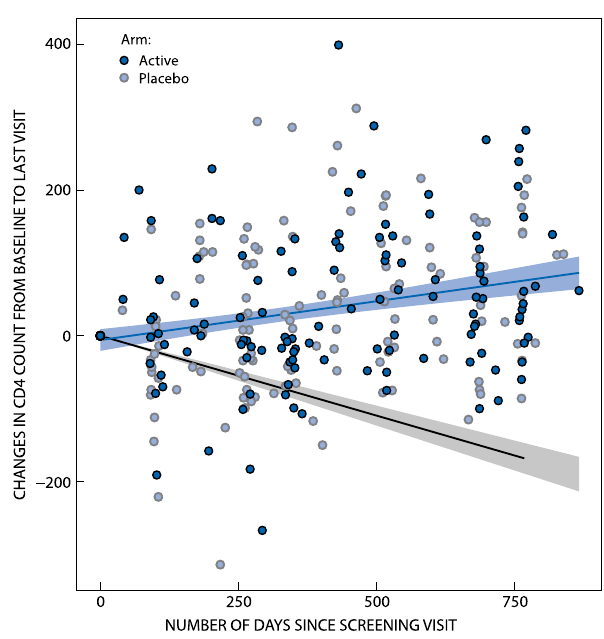
Figure 2: Summary of CD4 changes from baseline superimposed on anticipated decline.